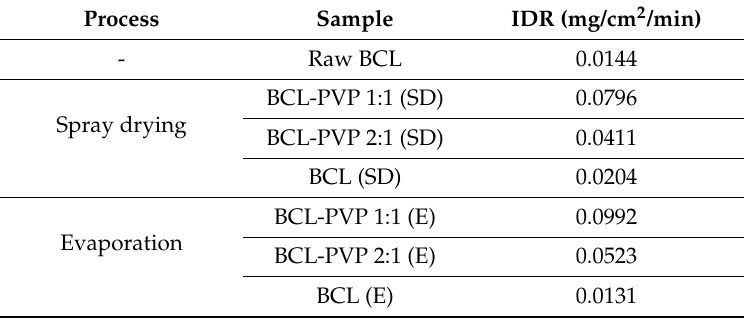
Table 3. Values of intrinsic dissolution rates of crystalline bicalutamide, drug processed alone and binary systems containing bicalutamide and PVP obtained using the evaporation technique (E) and spray drying (SD).